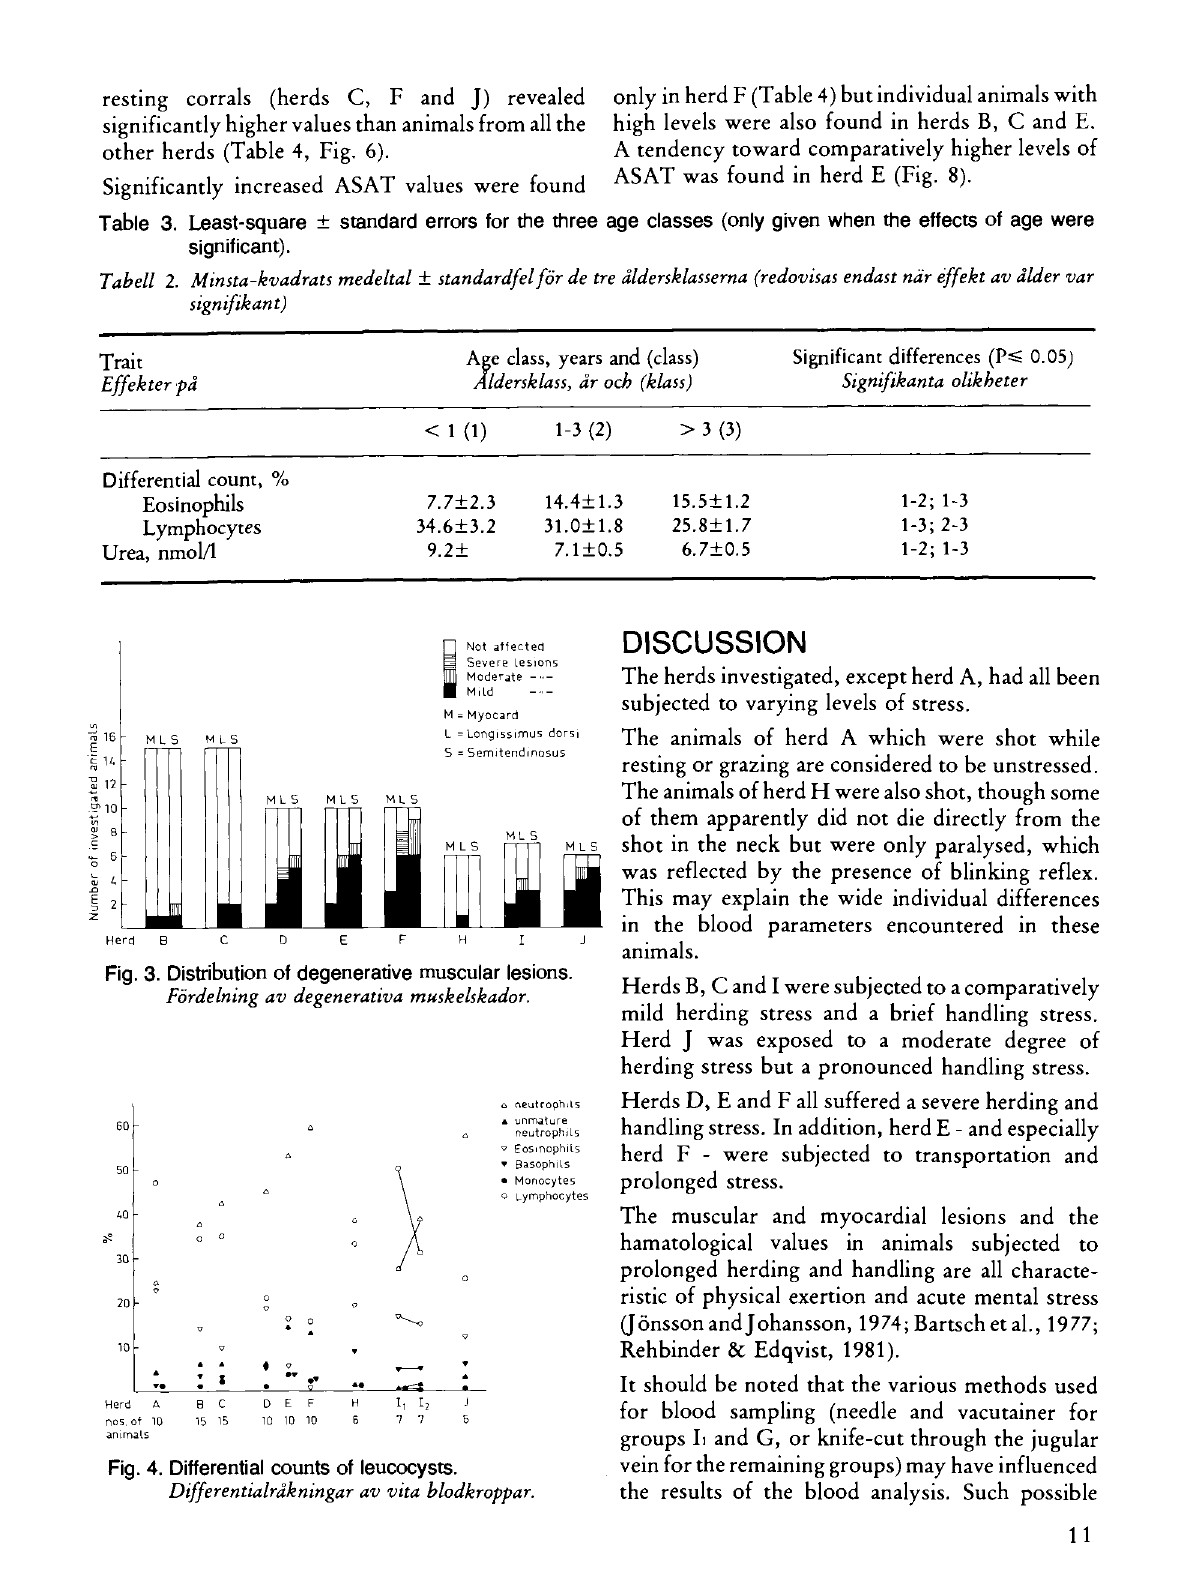
Table 3. Least-square ± standard errors for the three age classes (only given when the effects of age were significant). Tabell 2. Minsta-kvadrats medeltal ± standard/el for de tre dldersklasserna (redovisas endast nar effekt av alder var signifikant)